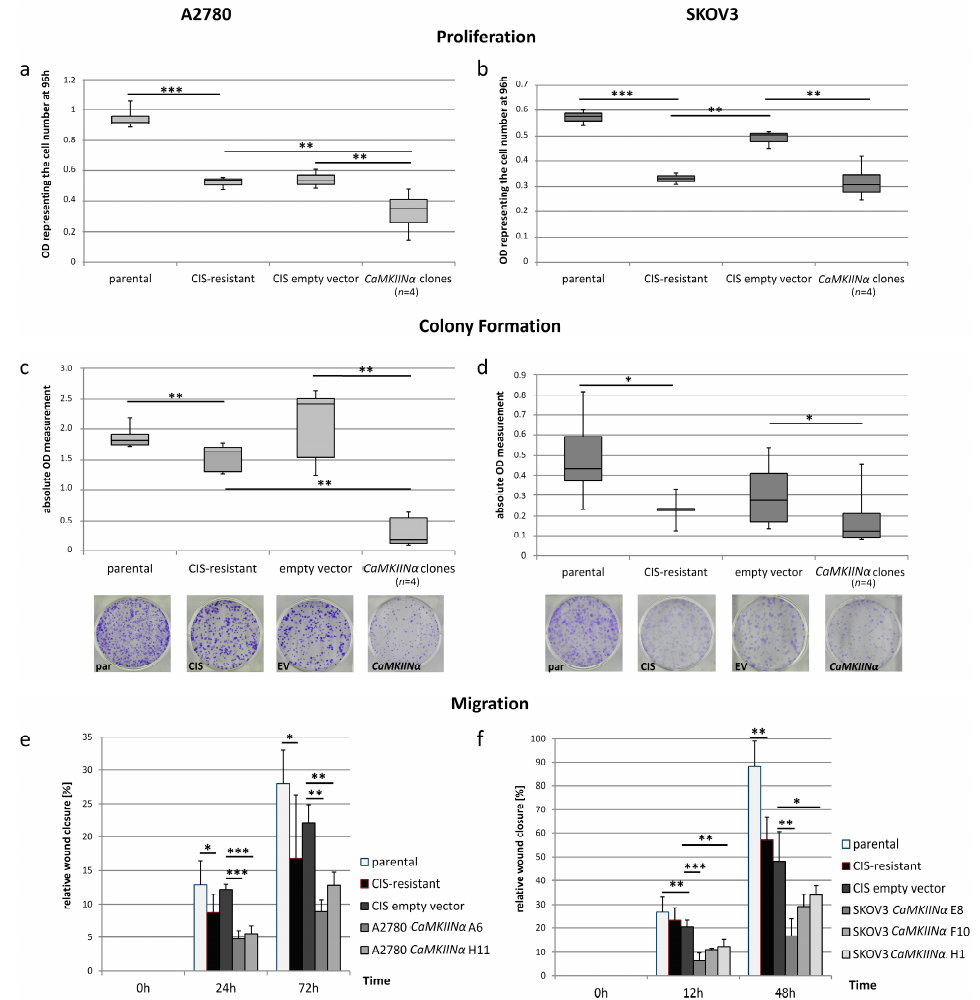
Figure 3. Effects of CaMKIIN α overexpression on cellular functions. ( a , b ) The CaMKIIN α